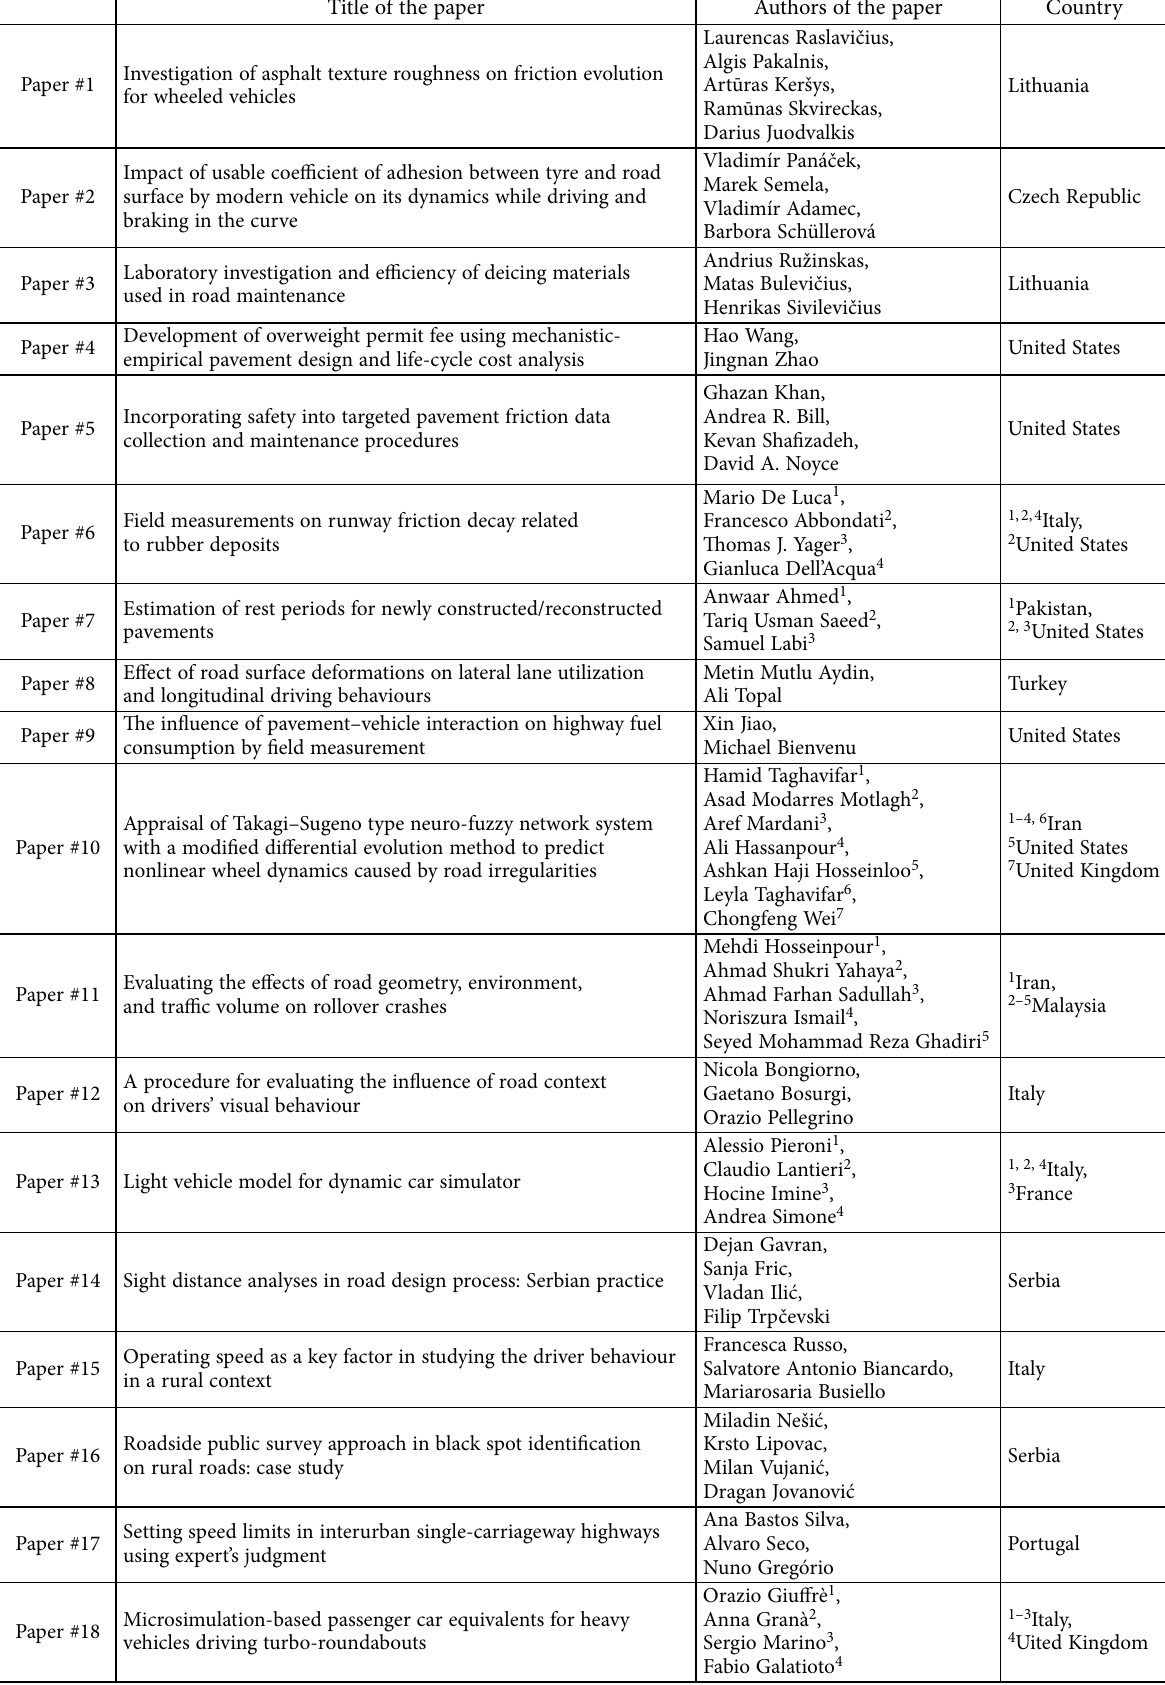
Table. Contents of the Special Issue on the Impact of Vehicle Movement on Exploitation Parameters of Roads and